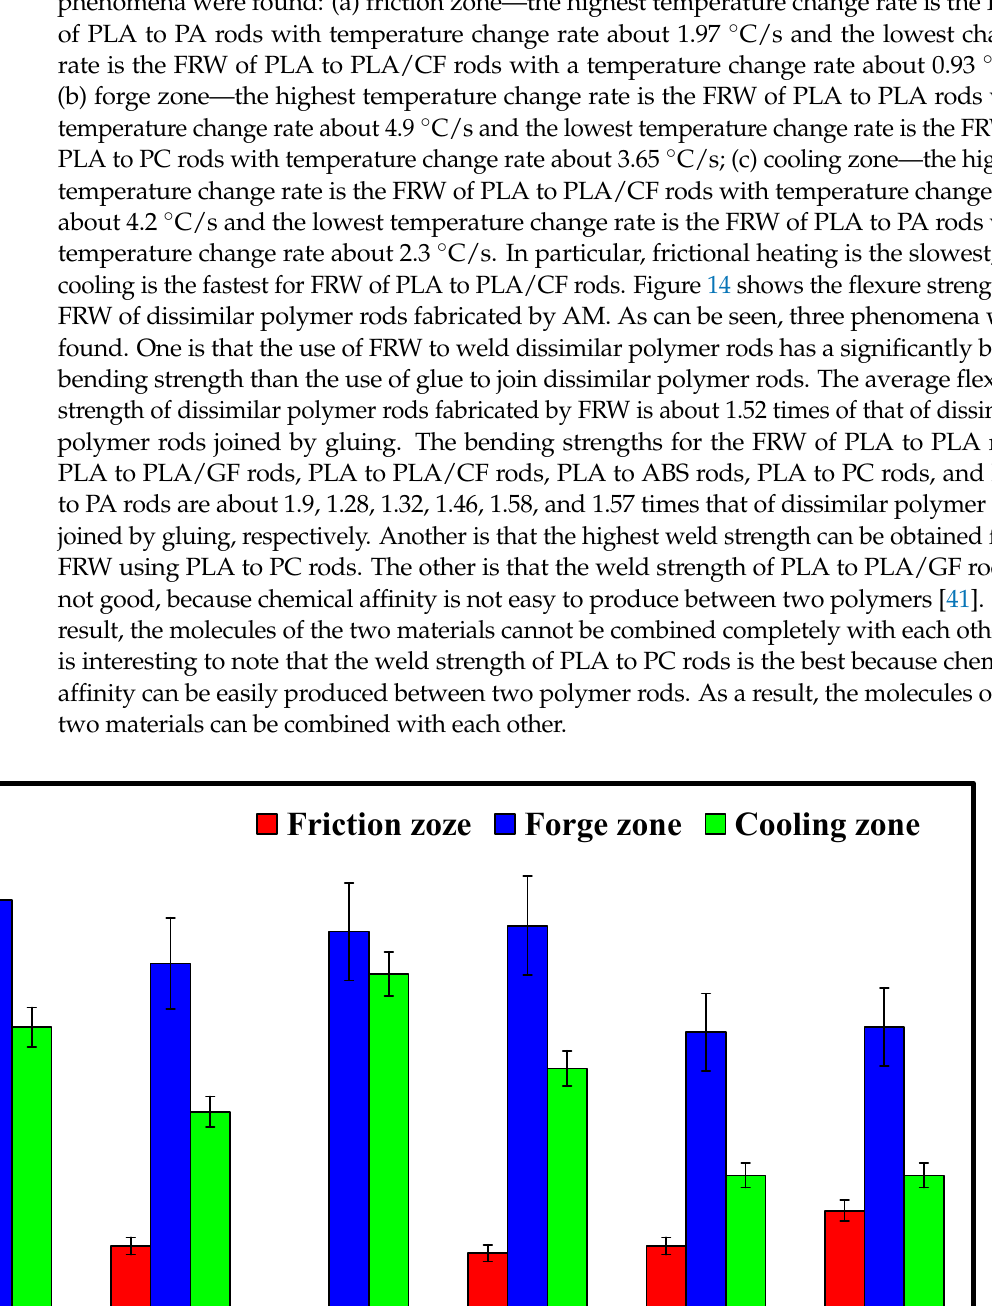
Figure 14. Flexure strength of dissimilar polymer rods fabricated by FRW and gluing. FRW led to a stronger bond because the process depends on inter-molecular bonding with the original material. Figure 14 shows the flexure strength of dissimilar polymer rods fabricated by FRW and gluing. Two typical fracture surfaces of dissimilar polymer rods after bending testing are shown in the inset. As can be seen, three phenomena were found. One is that the use of FRW to weld dissimilar polymer rods has a significantly better bend- ing strength than the use of glue to join dissimilar polymer rods. The average flexural strength of dissimilar polymer rods fabricated by FRW is about 1.52 times of that of dis- similar polymer rods jointed by gluing. The bending strengths for the FRW of PLA to PLA rods, PLA to PLA/GF rods, PLA to PLA/CF rods, PLA to ABS rods, PLA to PC rods, and PLA to PA rods are about 1.9, 1.28, 1.32, 1.46, 1.58, and 1.57 times of that of dissimilar polymer rods jointed by gluing, respectively. Another is that the highest flexure strength can be obtained by FRW using PLA to PC rods. The other is that the flexure strength of